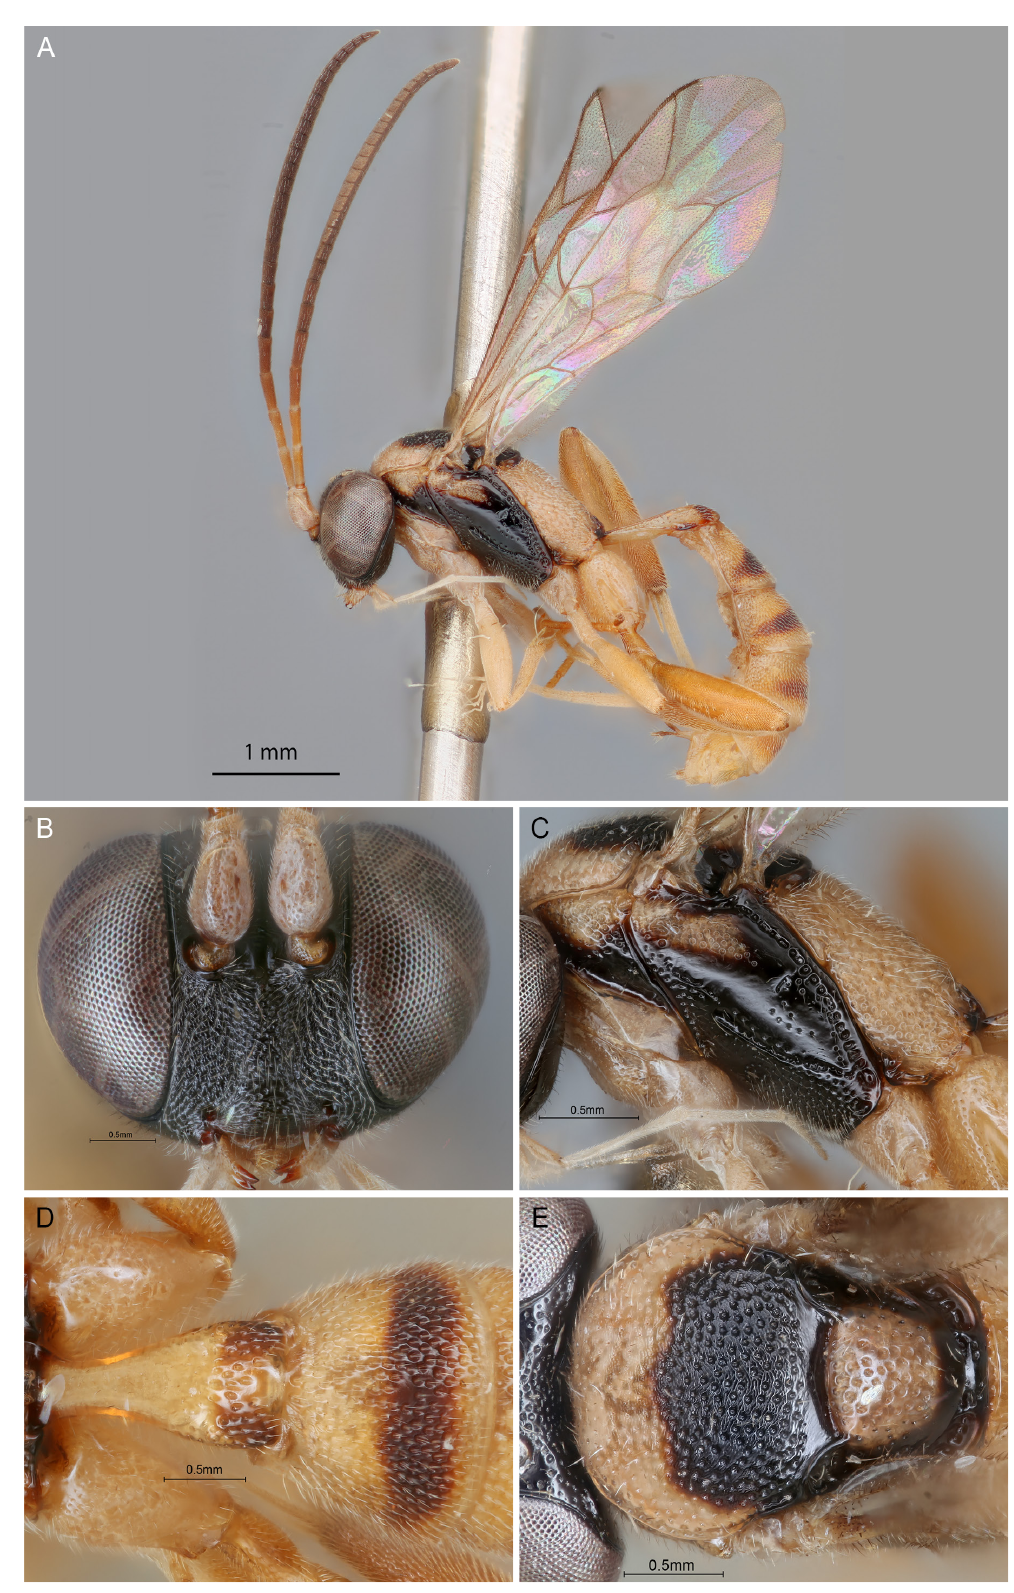
Fig. 15. Palpostilpnus ranui sp. nov., holotype, ♀ (NHMUK). A . Lateral habitus. B . Head, anterior view. C . Mesopleuron. D . T1 and T2, dorsal view. E .